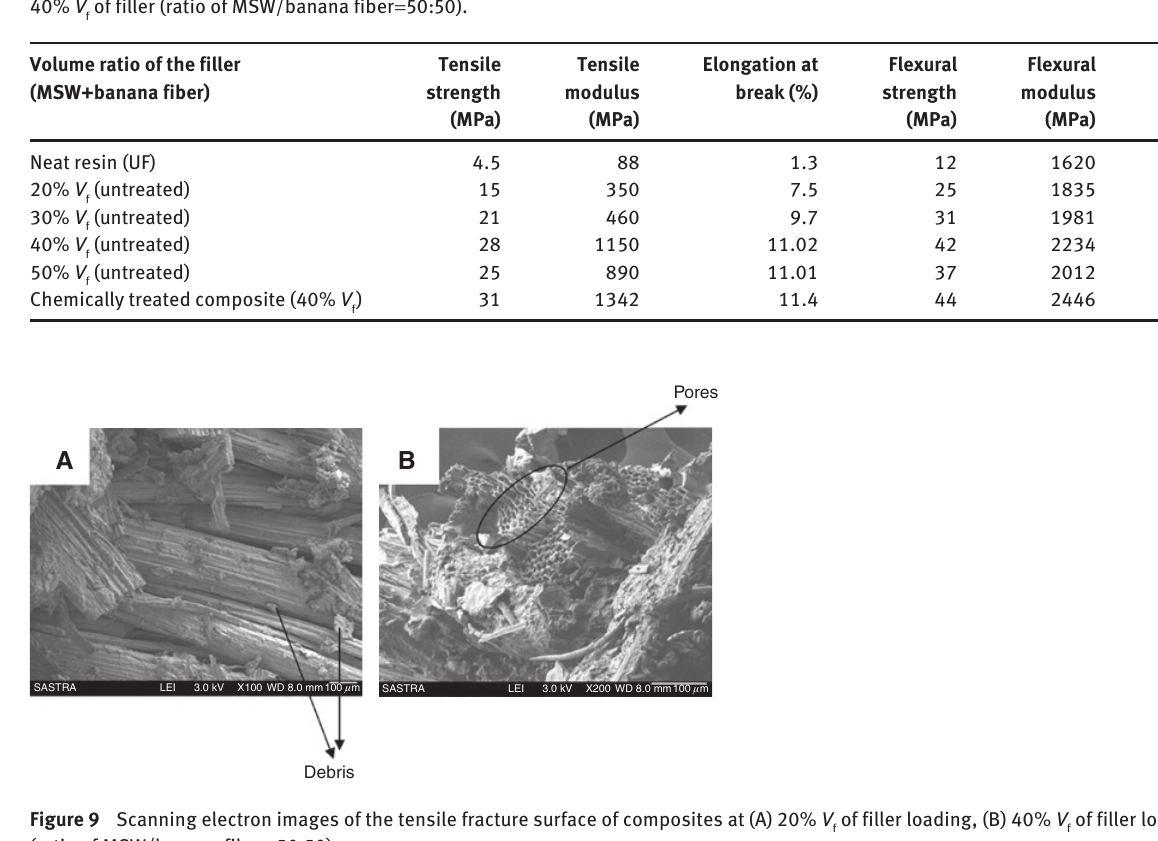
of filler loading, (B) 40% V of filler loading f f